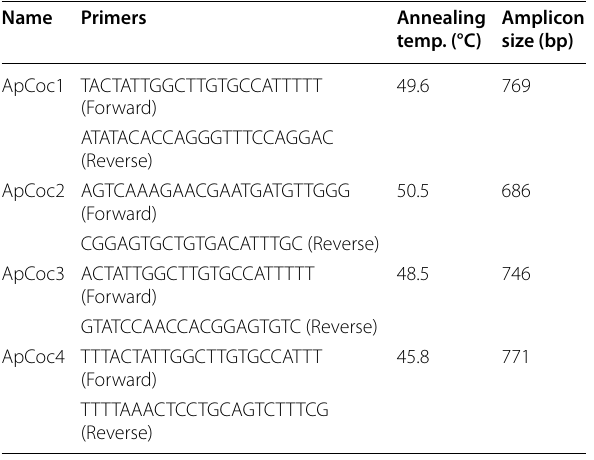
Amplicon temp. (°C) size (bp)